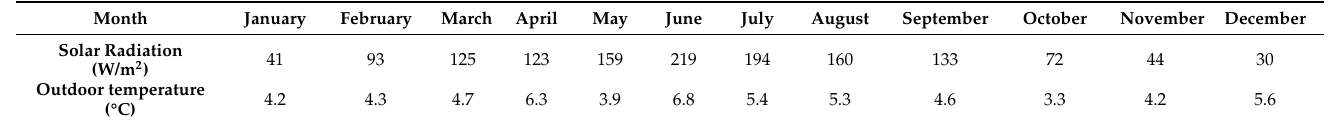
Table 2. Mean absolute difference between monitored (2018–2019) and typical meteorological year values for outdoor dry bulb temperature and solar radiation, per month.